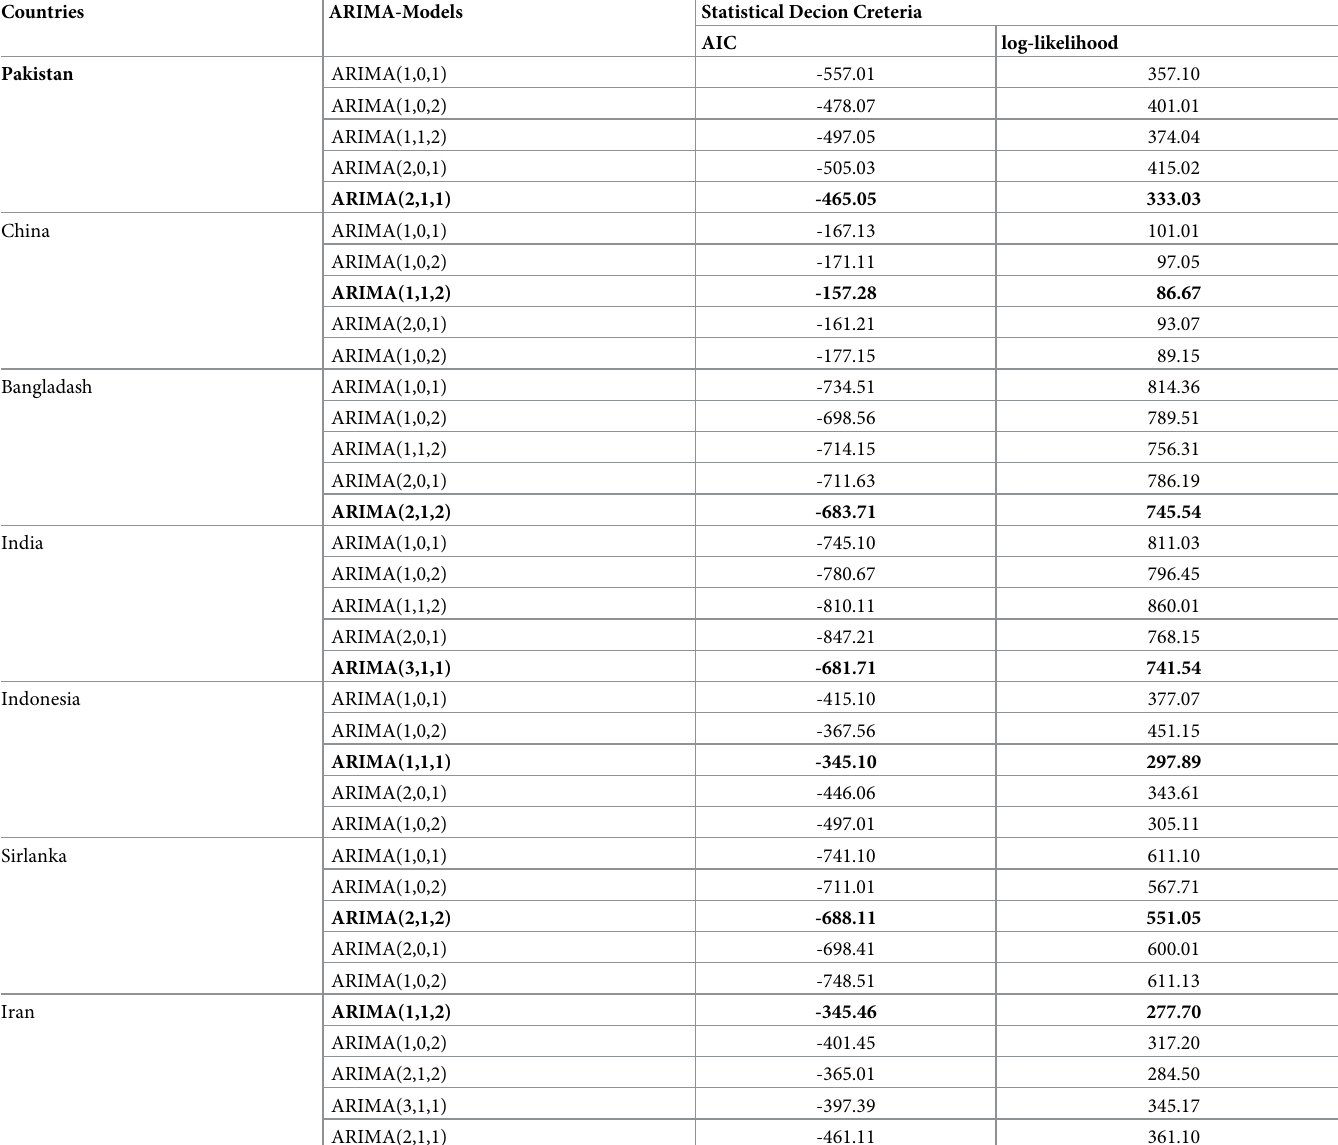
Table 2. Best model selection through information criteria (AIC and